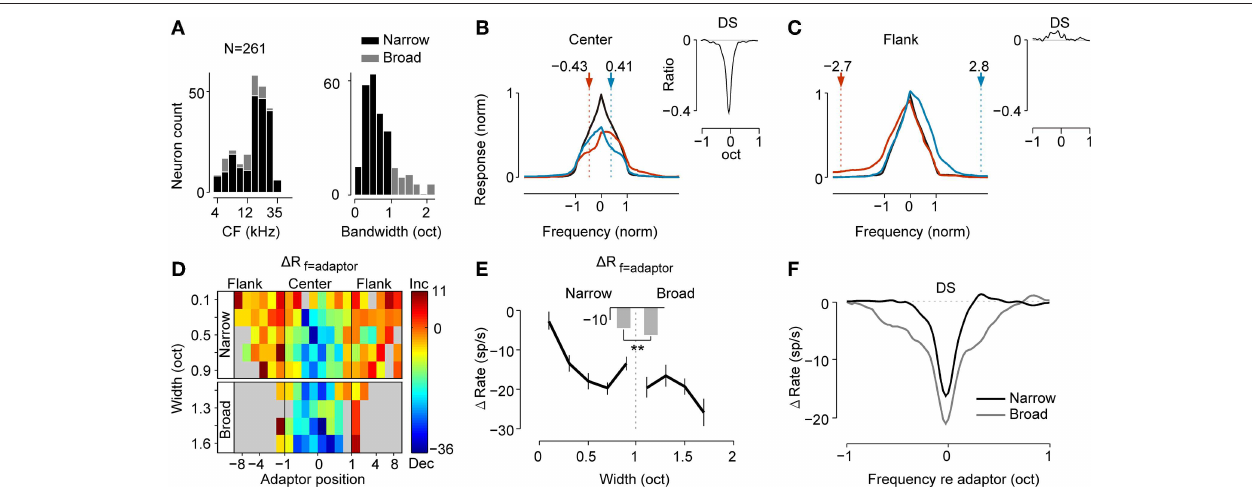
FIGURE 2 | Population analysis reveals suppression and facilitation in frequency tuning and its dependence on the adaptor position and the bandwidth of the neuron. (A) Distributions of CF (left) and bandwidth (right) of neurons ( n = 261 ). Neurons with BW < 1 octave were defined as narrowly tuned neurons (black, n = 214 ) and others were defined as broadly tuned neurons (gray, n = 47 ). (B,C) Averaged original (black) and adapted tuning (colored) when adaptors were located in the center (B) or flank (C) of the RF. The adaptor was either below (red) or above (blue) the original BF. Each curve was coordinated to the center at the BF and was normalized to its maximal response and bandwidth before averaging. Dashed lines and arrows: the averaged location of adaptors in both cases. Insets: the averaged difference signal (DS) between the original and adapted tuning. DS of each neuron was normalized by the peak firing of the original tuning and was centered at the adaptor before averaging. (D) The dependence of the magnitude of local suppression at the adapting frequency ( 1 R f = adaptor ) with the adaptor position (abscissa) and bandwidth of the neuron (ordinate). Narrowly and broadly tuned neurons were separated with 1 octave BW as the boundary. The thick black vertical lines divided the regions with the center and flank adaptor with the RF edge as the boundary. Strong suppression was concentrated in the center region, especially for broader neurons. (E) Dependence of the 1 R f = adaptor on the bandwidth of the neuron when the adaptor was within the RF (mean ± SE). The mean values for narrowly and broadly tuned neurons are compared as bars in the middle demonstrating significantly stronger suppression for broadly tuned neurons (Wilcoxon rank sum test, p = 2 . 8 × 10 − 6 ). (F) Mean DSs for narrowly and broadly tuned neurons when adaptors were within the RF (coordinated to the adaptor before averaging). Adaptation caused a significantly broader suppression range for broadly tuned neurons (BW broad = 1.4 octaves, BW narrow = 0.5 octaves, Wilcoxon rank sum test, p = 4 . 5 × 10 − 11 ).